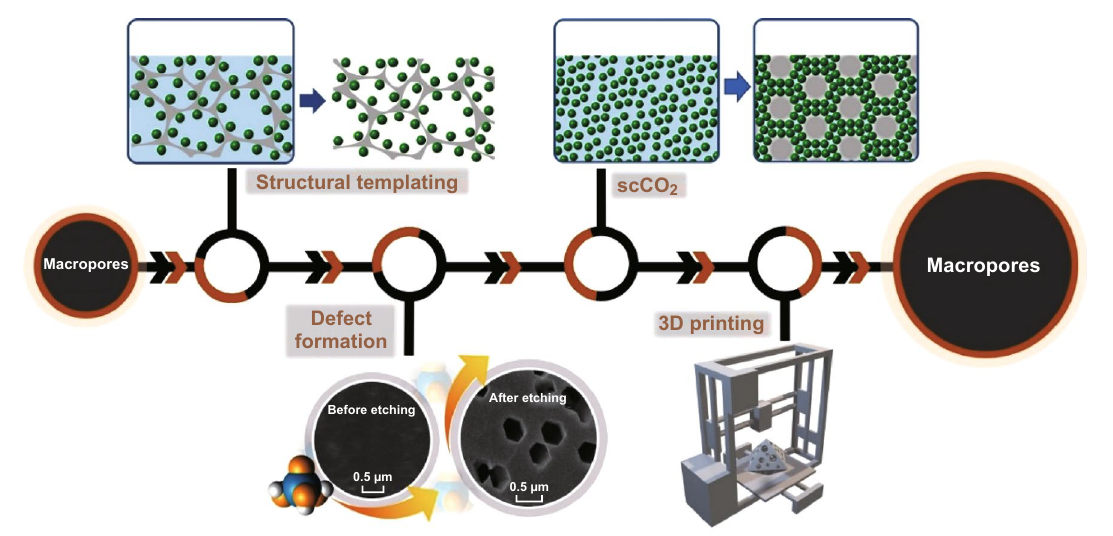
Fig. 1 Schematic representation of synthetic methods for hierarchical MOFs with